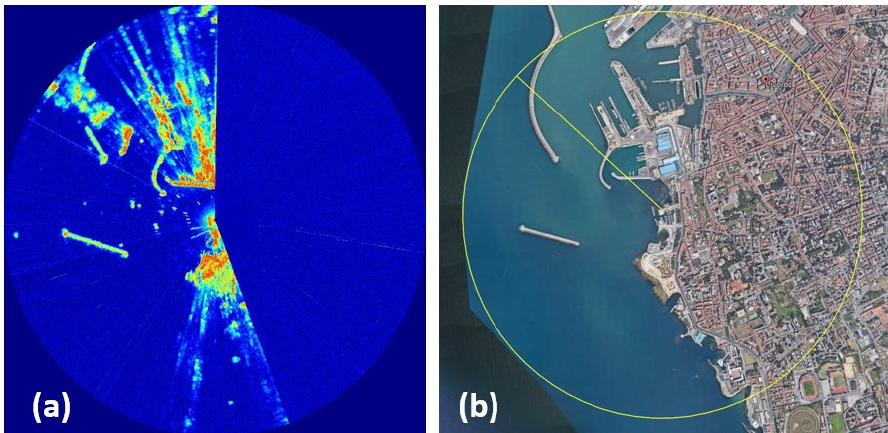
Figure 2. ( a ) Radar image of the survey area; ( b ) aerial image of the survey area (Google, images © 2019 CNES).